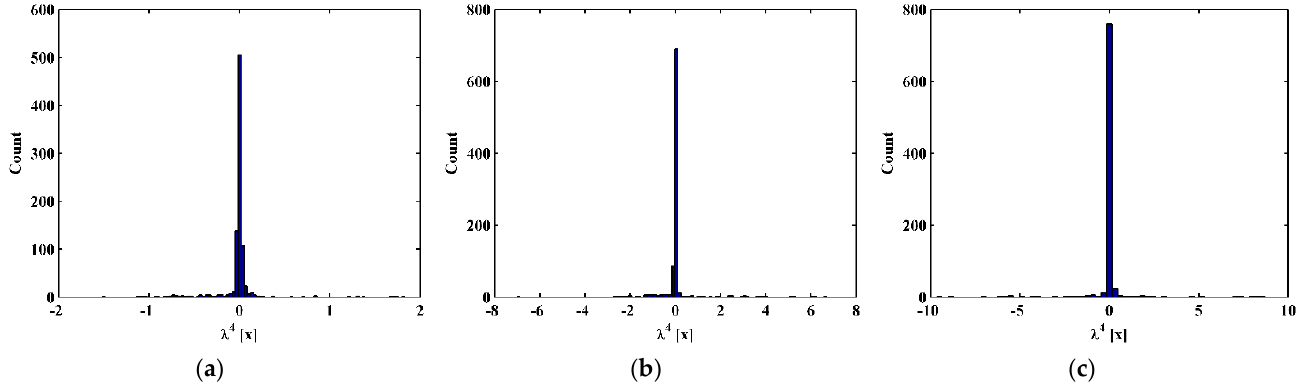
4 [ ] x λ Figure 7. Distributions of constants λ 4 [ x ] for the ( a ) third, ( b ) fourth, and ( c ) fifth mode Figure 7. Distributions of constants for the ( a ) third, ( b ) fourth, and ( c ) fifth mode shapes.